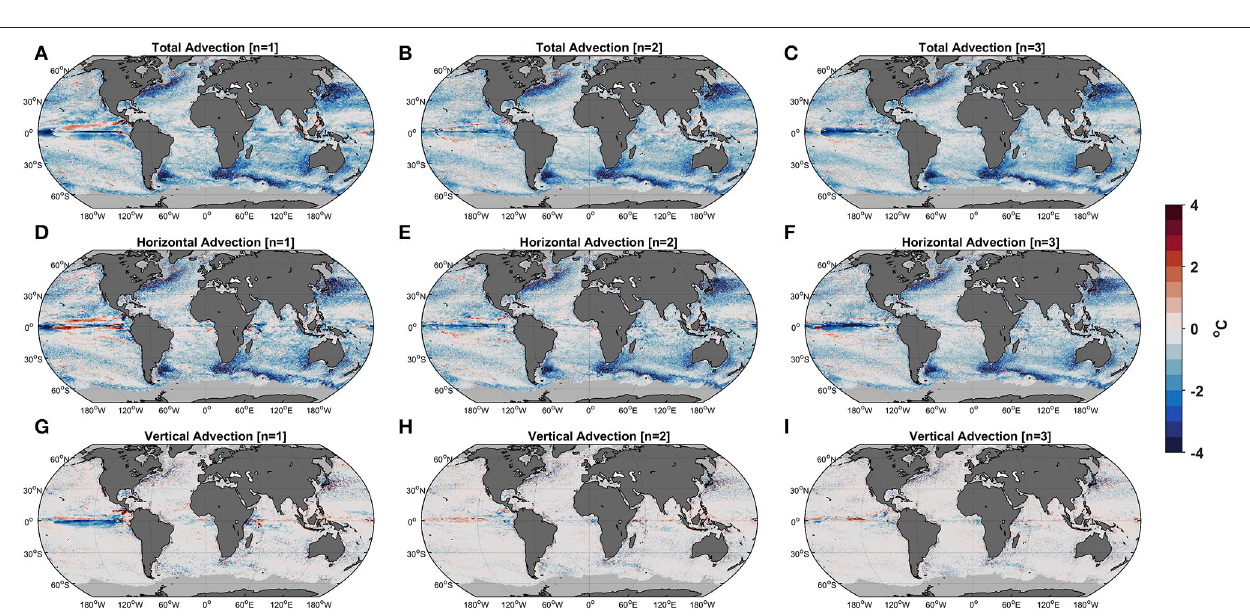
FIGURE 5 | Decomposition of the heat advection term for the onset of the three strongest MHW events. (A–C) Total heat advection contribution to depth-averaged temperature anomaly change. Total heat advection was decomposed into its (D–F) horizontal component and (G–I) vertical component. Positive/negative values correspond to heat convergence/divergence. Grid points where onset periods started before Jan-1st 1984 or with sea-ice contamination were excluded from the analysis (gray shading).